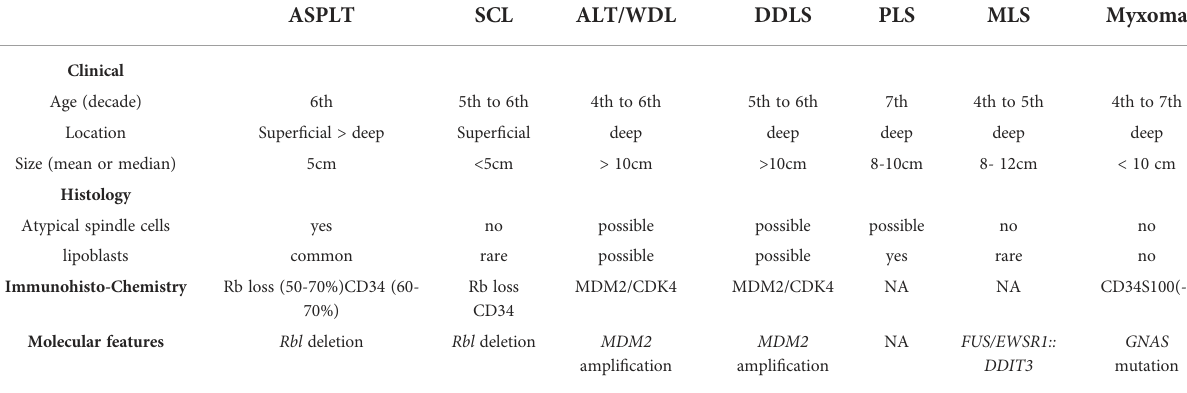
TABLE 1 Differential diagnosis of atypical spindle cell/pleomorphic lipomatous tumor. ASPLT SCL ALT/WDL DDLS PLS MLS